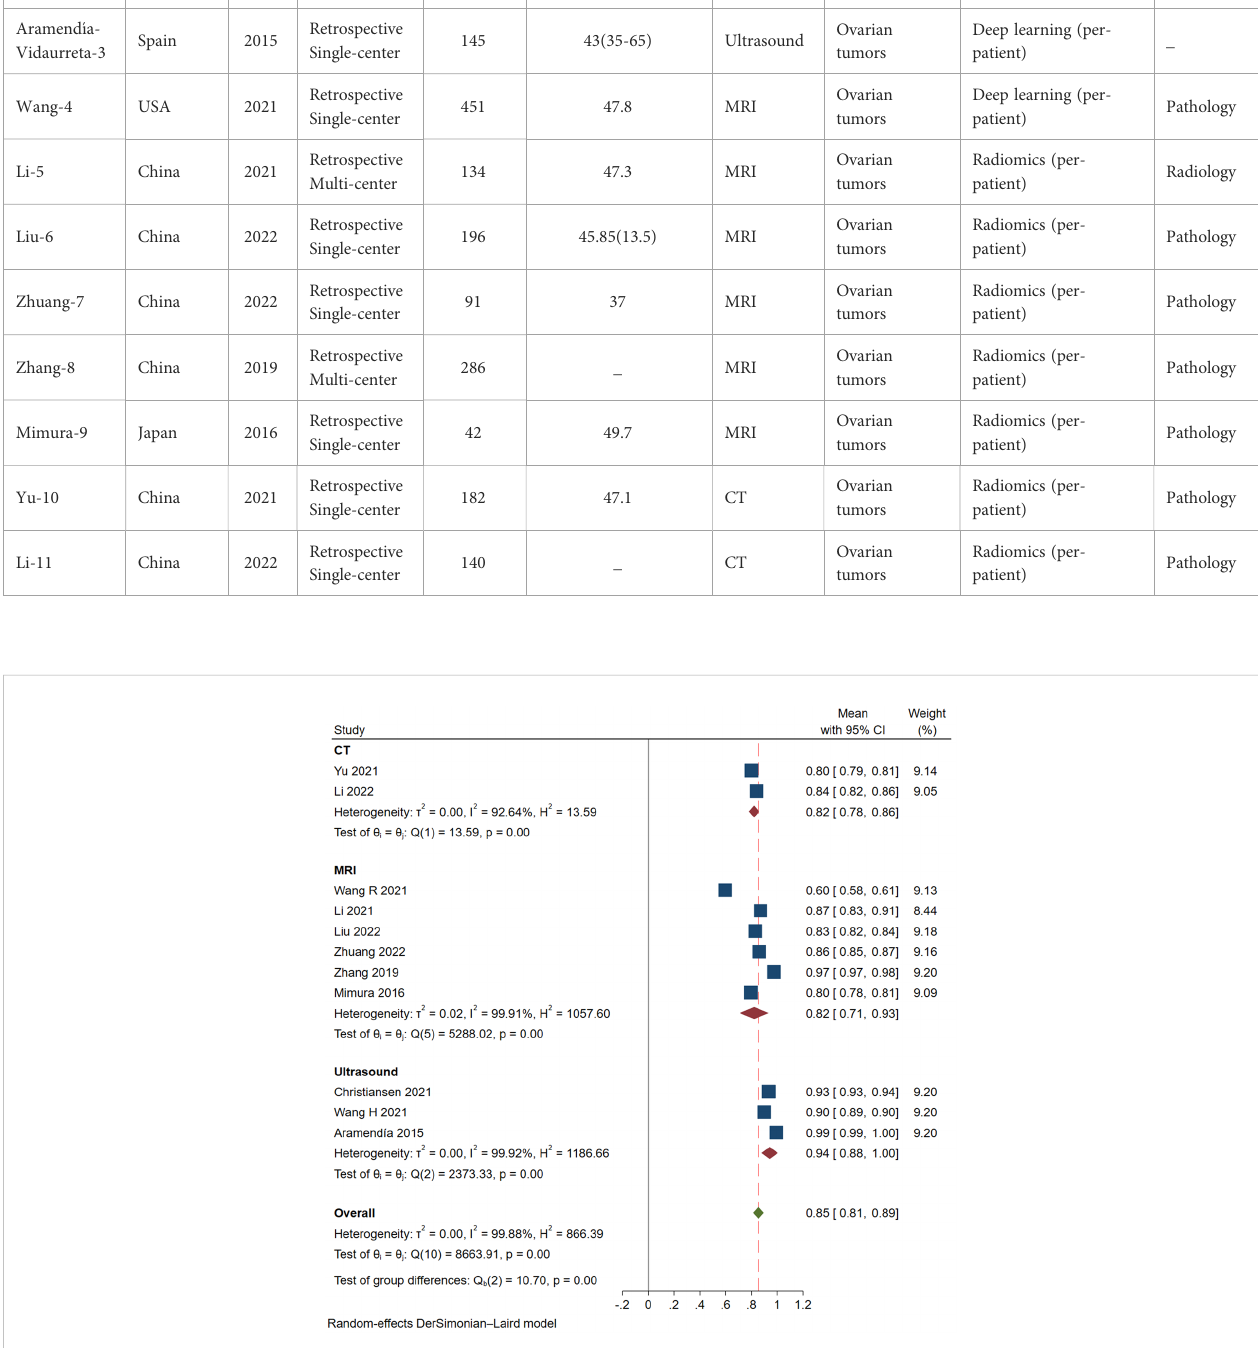
FIGURE 2 Forest plots of